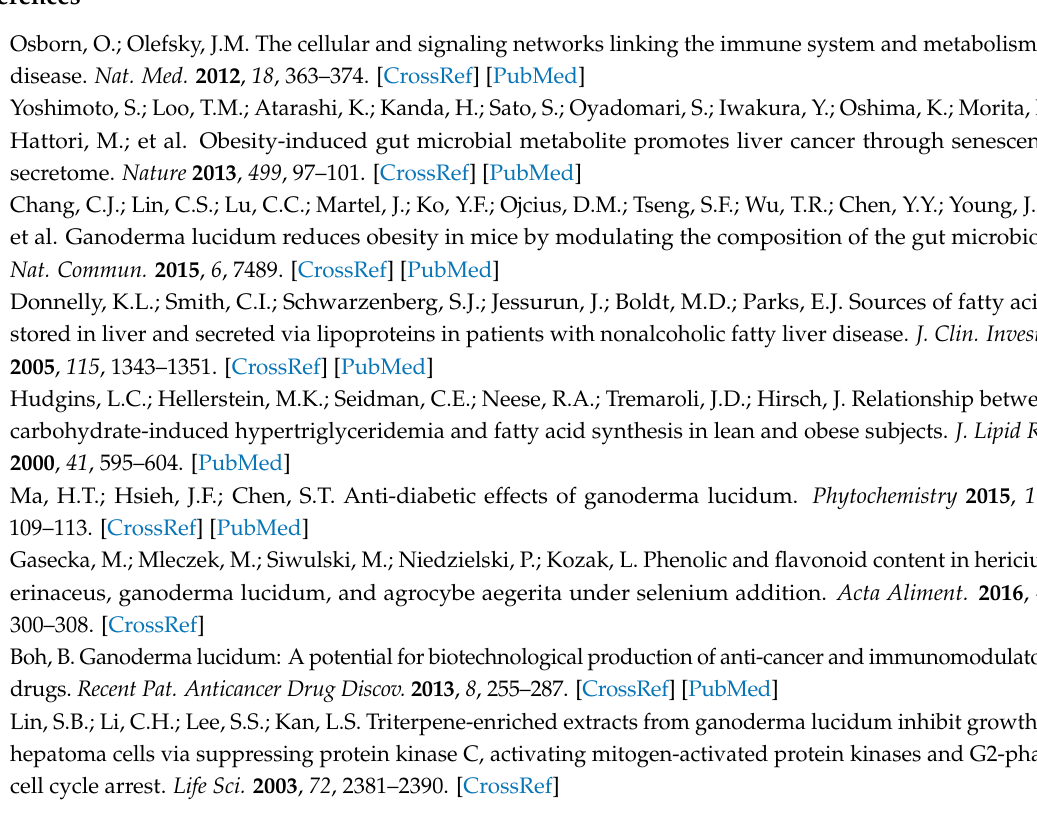
Table S1: β -Glucan and soluble vitamins contained in Genoderma Lucidum extract. Author Contributions: S.J., H.S. and C.E.H. performed the experiments and analyzed the data. K.M.C., S.W.P. and H.J.K. designed the experiments, interpreted the data and prepared the